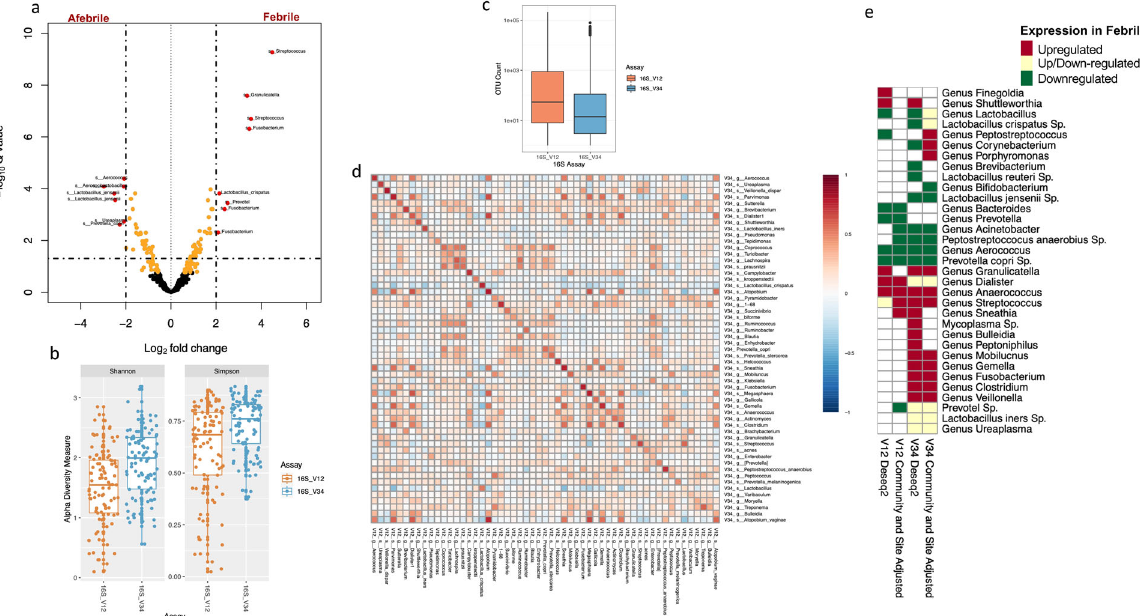
Fig. 4 Differential vaginal bacterial presence in febrile vs. afebrile laboring women utilizing V1 – V2 and V3 – V4 hypervariable regions. a Volcano plot representing differentially abundant bacteria in febrile vs. afebrile women using V3 – V4 regions. Orange points signify P < 0.05 and labeled red points bacterial OTUs with adjusted P < 0.05 (Bonferroni correction). s_ represent species level and g_ denotes genus level classi fi cation of OTUs. b α -Diversity across the V1 – V2 vs. V3 – V4 assay. c Count per OTU in relevance to assay. d Spearman ’ s correlations of samples above zero counts in both V1 – V2 and V3 – V4 regions (OTUs agglomerated at species level). Spearman ’ s correlation measures are between ( − 1,1). e Heatmap table of differentially abundant bacterial OTU concordance utilizing V1 – V2 and V3 – V4 regions from DeSeq2 analysis ( P < 0.05) (it is noteworthy that the fi gure is portrayed in increase and decrease in bacteria with and without covariates (site and community assignment CMT) in the Deseq2 model,